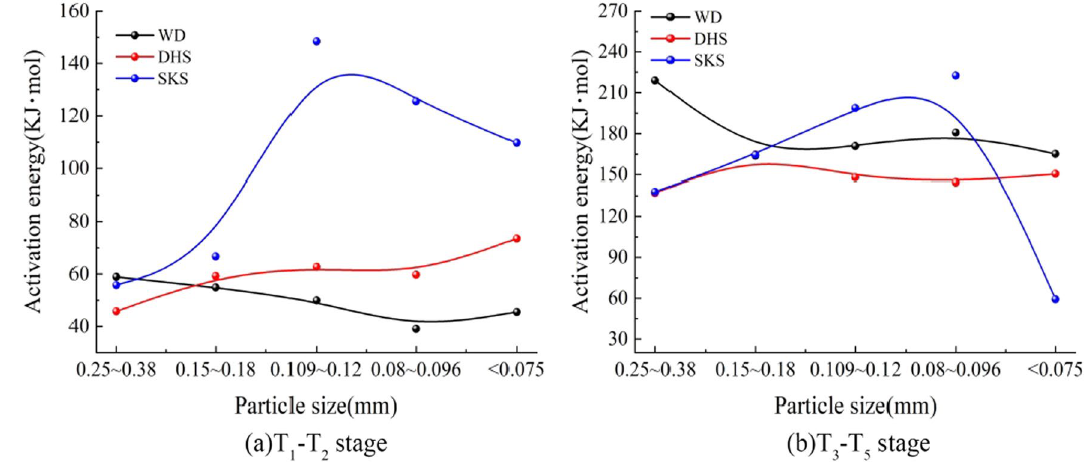
Fig. 11 Activation energies for coal samples at the T